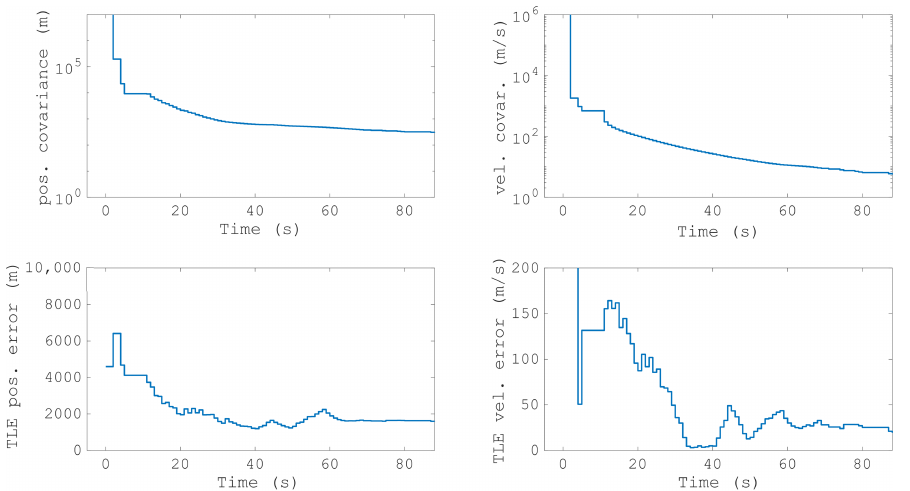
Figure 14. The resulting orbit predictions from the measurements from Figure 13. The top row shows the covariance of the position estimate and the velocity estimate; the bottom row shows the mean error when compared with the